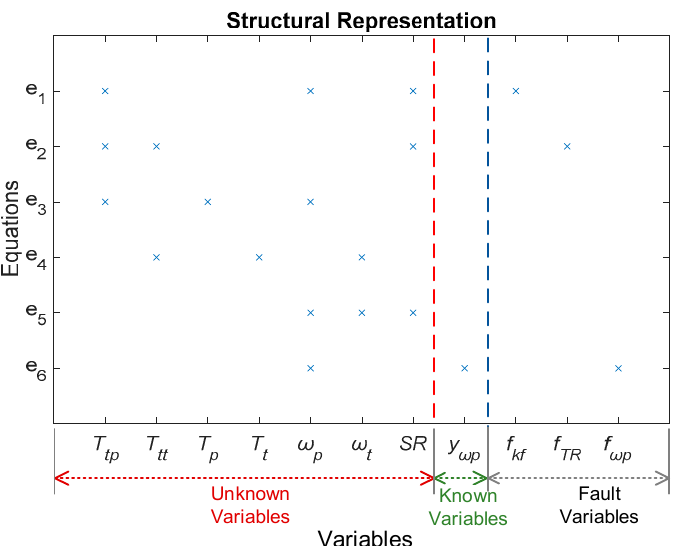
Figure 4. Structural representation of the HTC, with variables classified into three categories: unknown, known, and fault variables; “ × ” indicates that the equation e i ( 𝑖 = 1–6) is associated with the corresponding variables.